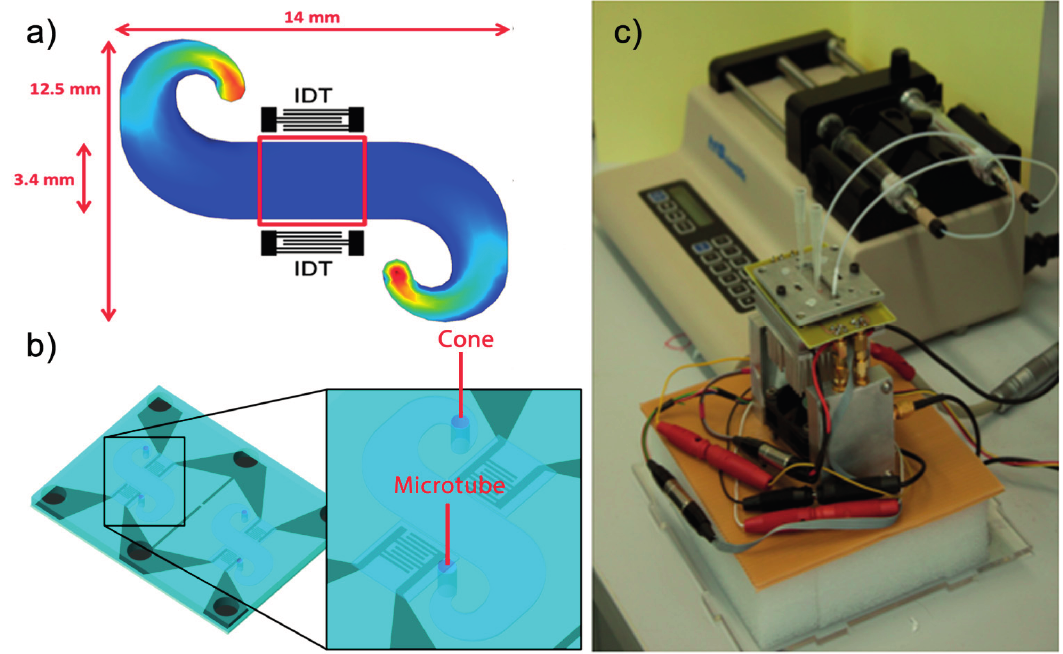
Figure 1. ( a ) Simulation of velocity of the liquid in the microchannel (in red the highest velocity and in blue the lowest one); ( b ) Love-wave device with two delay lines and a microfluidic chip of PDMS forming a microchannel; ( c ) Photography of the liquid cell and syringe